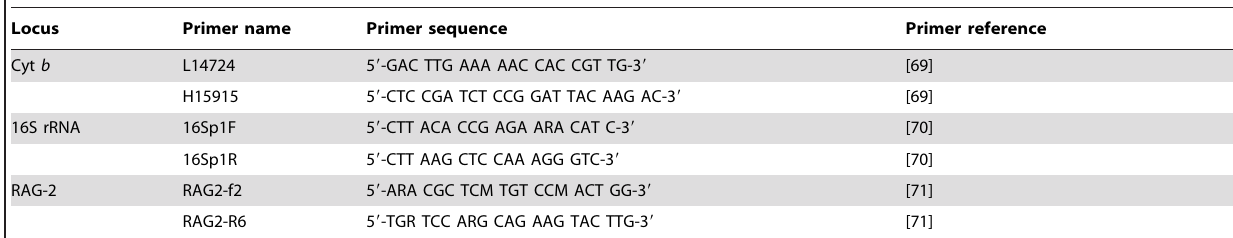
Table 2. Primers used for PCR and